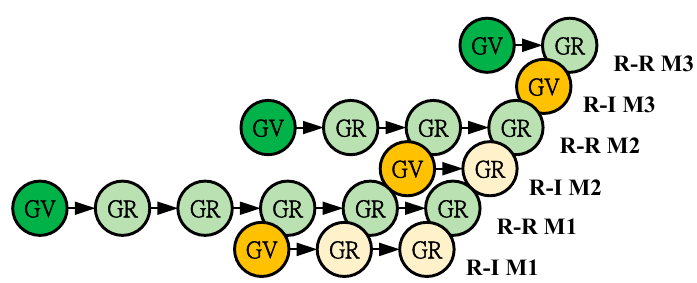
Figure 15. Systolic array design of the QR decomposition module.